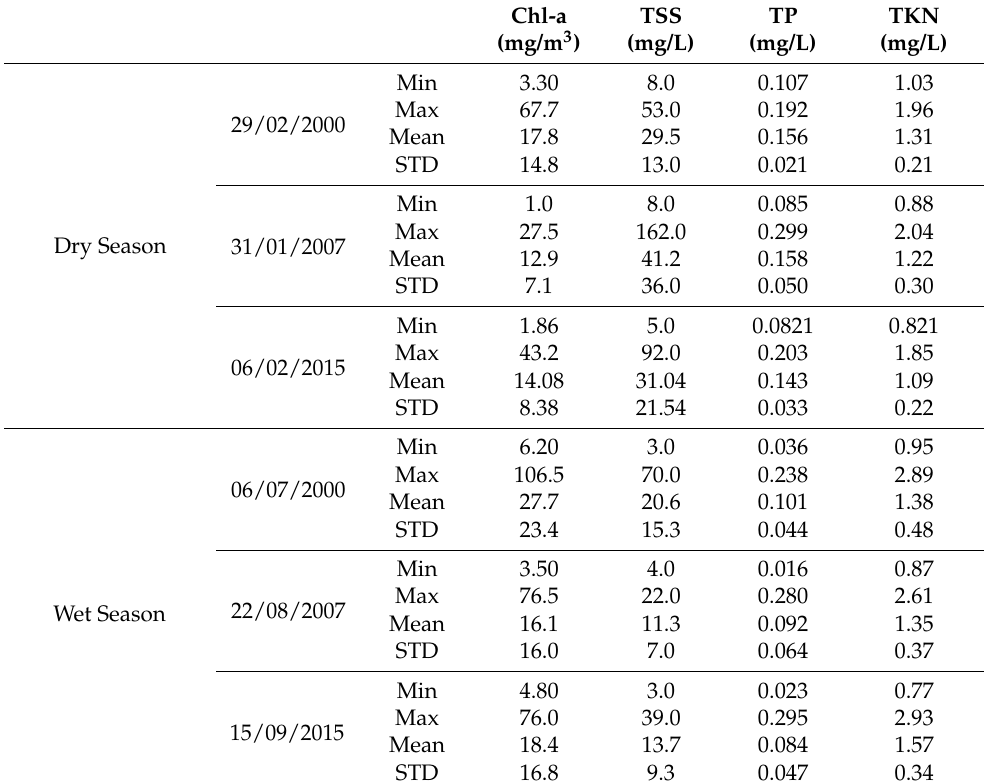
Table 1. Descriptive statistics of observed water quality parameters from the 26 stations of Lake Okeechobee. The dates correspond to the satellite imagery